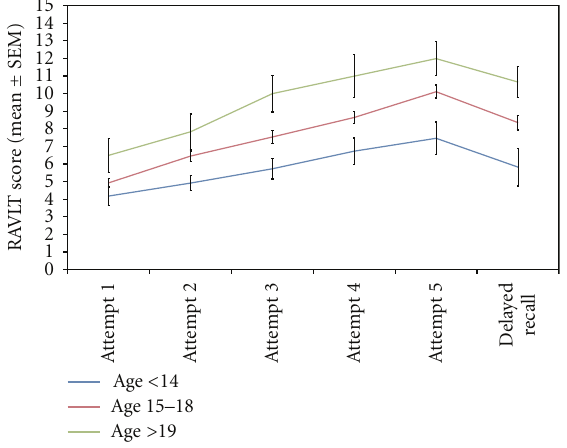
Figure 2: Rey audio-verbal learning test scores during 5 repetitions, and then after a delay, grouped by age left full-time